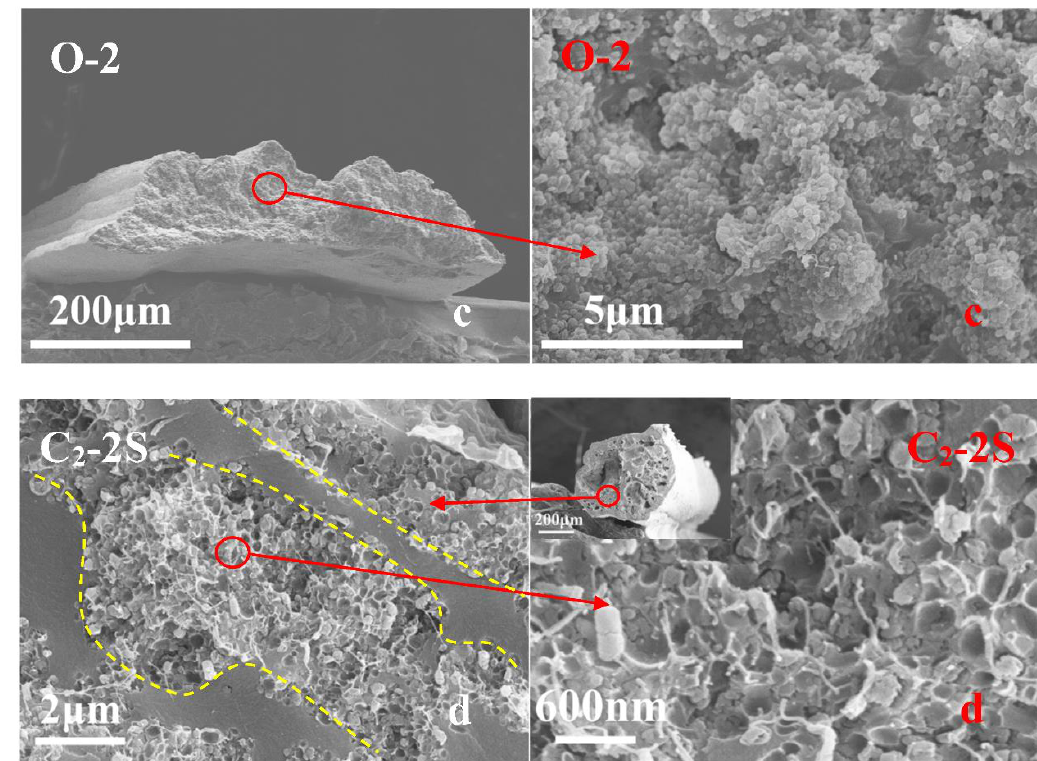
Figure 7. SEM images of the fibers obtained before and after sintering; fiber O-2 is defined in Section 2.3, and fiber C 2 -2S is described in Section 2.4; the surface of fiber O-2 (a), the surface of fiber C 2 -2S (b), the cross section of fiber O-2 (c) and the cross section of fiber C 2 -2S (d).